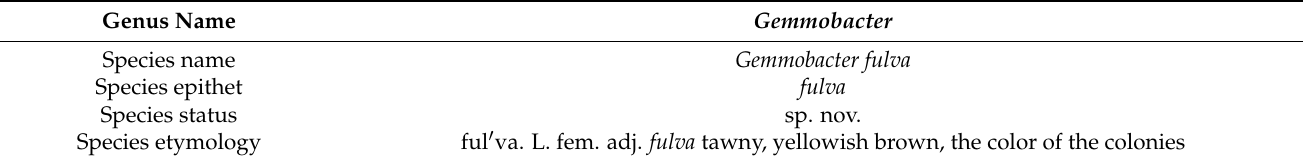
Table 3. Descriptions of Gemmobacter fulva sp. nov.